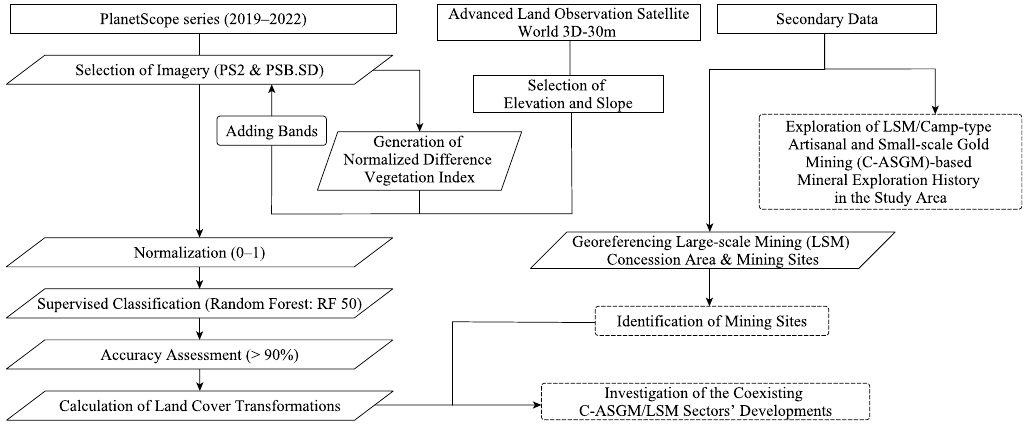
Figure 1. Overall methodology.